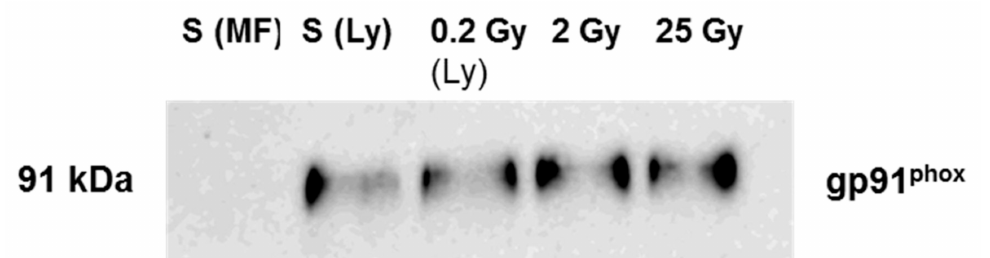
Figure 5. Gp91 phox detection in total lysate of irradiated and non-irradiated PLB cells . S(MF) repre- sents the membrane fraction from sham (non-irradiated PLB-cells); S(Ly) represent the total cell lysate of sham; subsequent lanes (Ly) represents the total lysate of PLB cells irradiated at 0.2 Gy, 2 Gy and 25 Gy, respectively. In each lane, 20 µ g of total membrane proteins (estimated from BCA assay) was deposited. The membrane fractions were heated for 5 min at 85 ◦ C, and subject to 10% SDS-PAGE and immunoblotting. Each membrane was incubated with a primary antibody (dilution 1:1500 for gp91 phox ). MF: Membrane fractions, Ly: